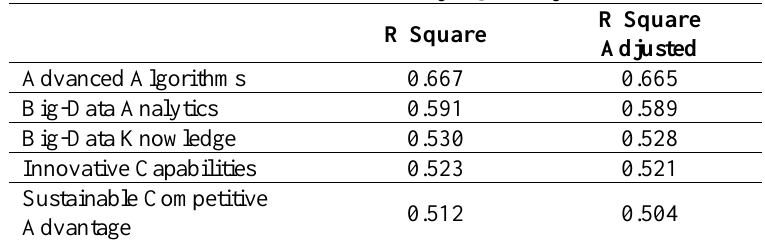
Table.2. Predictive Accuracy (Quality Criteria)